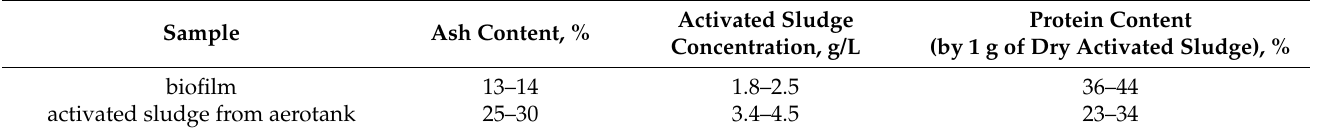
Table 1. The characteristics of biofilm and activated sludge samples.